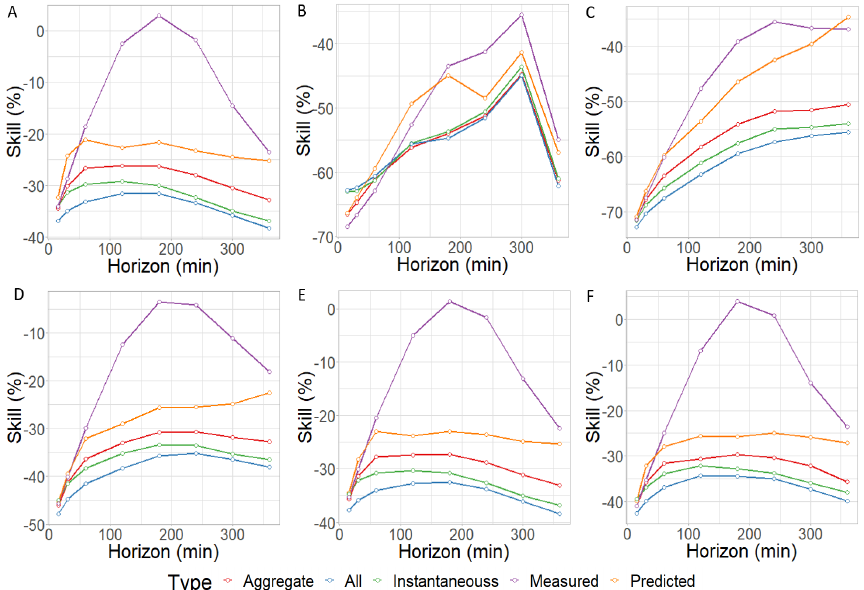
Figure 2. Skill for all modules considering different inputs to the ML algorithm. Top row : NRMSE of panels A, B and C. Bottom row : NRMSE of panels D, E and